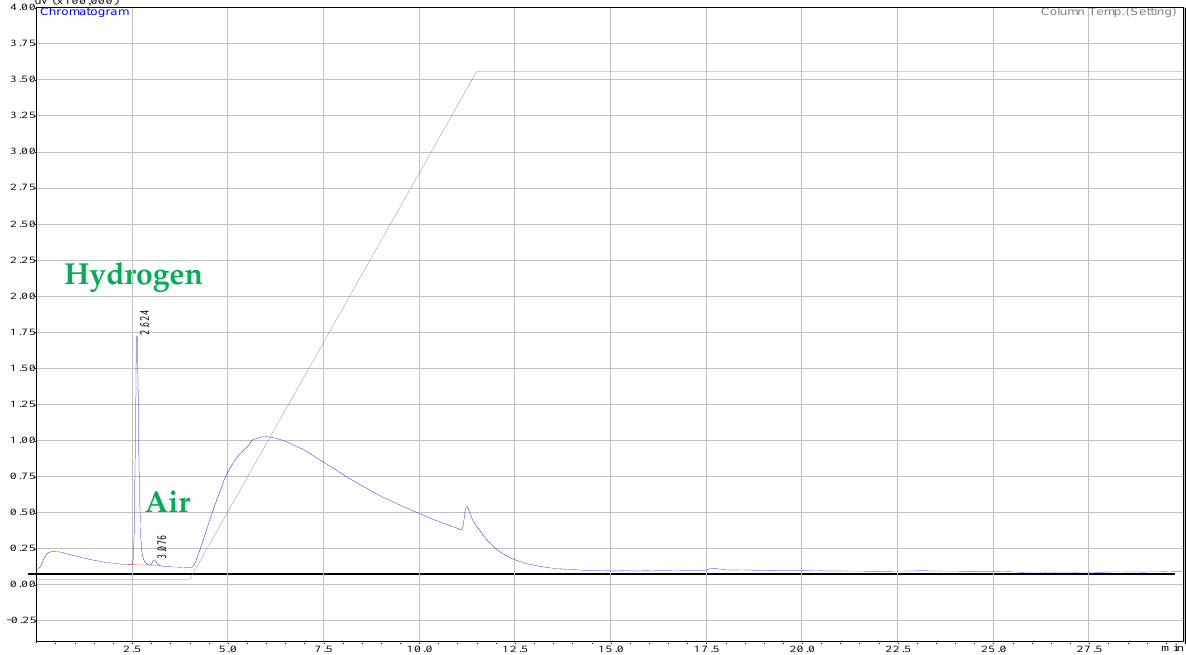
Figure A1. Hydrogen peak as detected by the TCD.